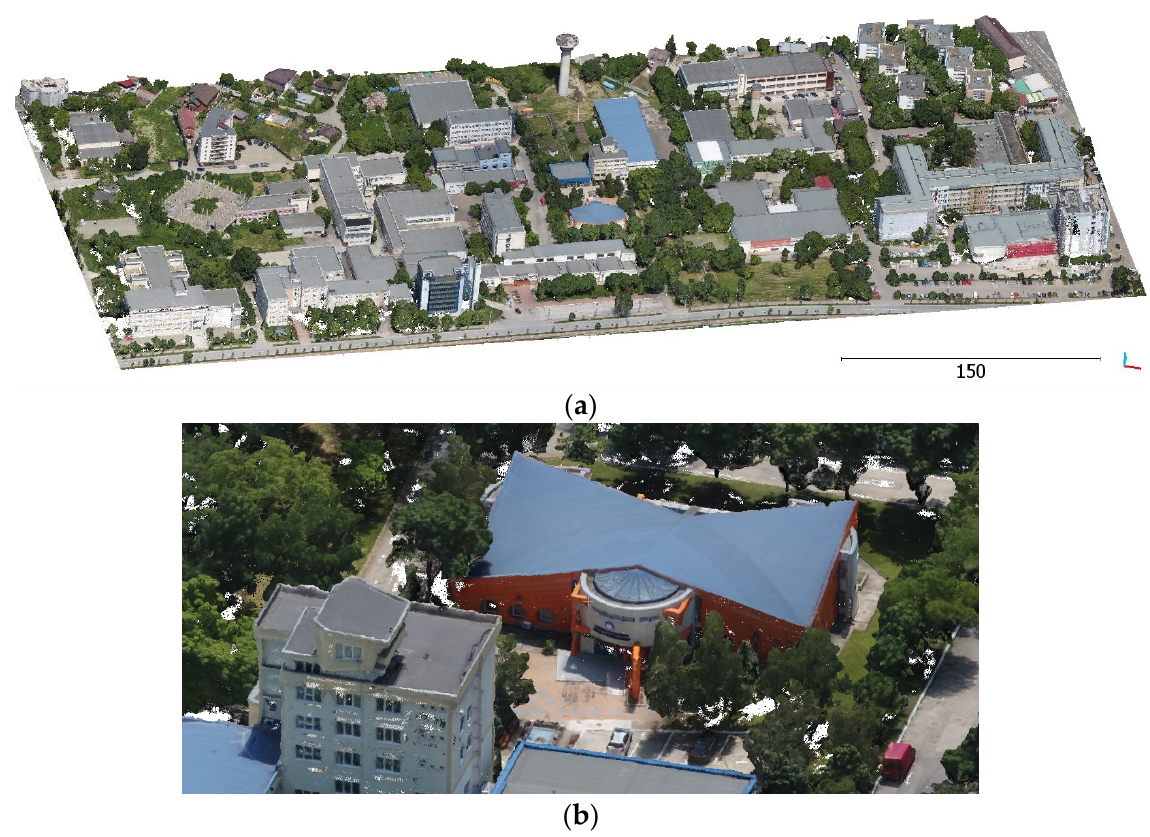
Figure 7. ( a ) UAV point cloud of the study area, ( b ) detail.